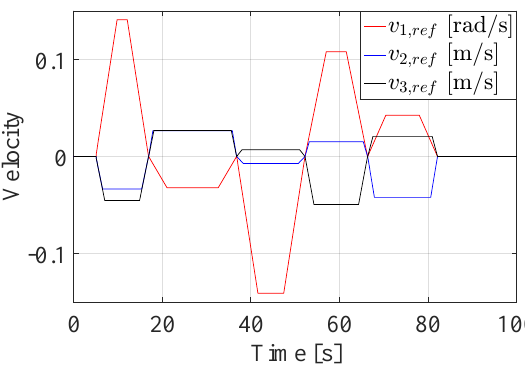
Figure 10. Example of trapezoidal velocity reference for three actuators.